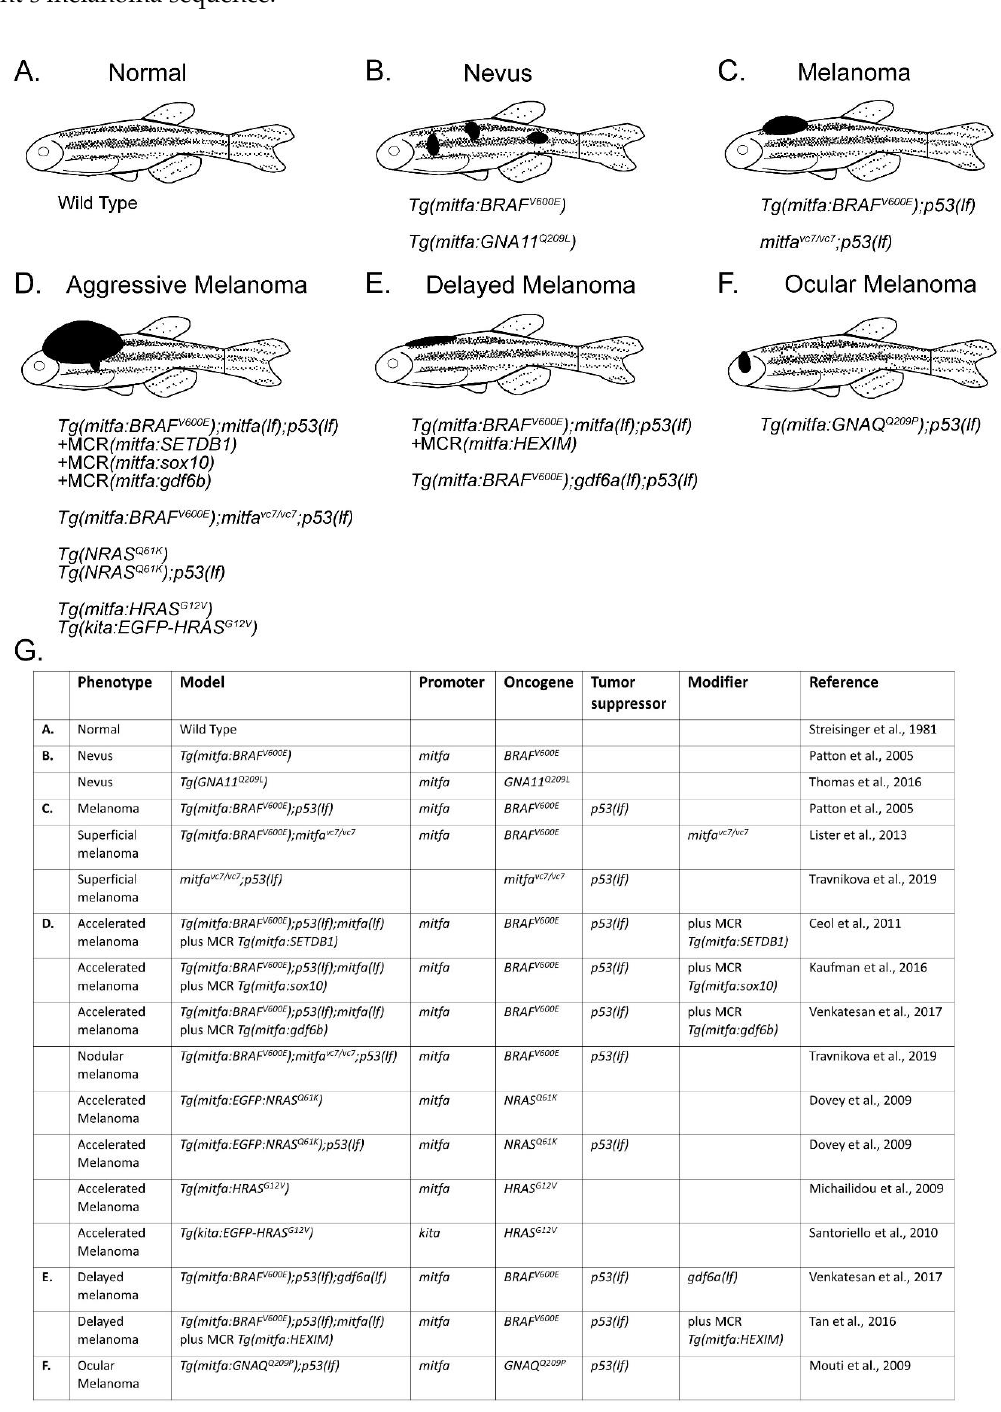
Figure 1. Genetic models of melanoma in zebrafish. ( A ) Normal melanocyte pattern in wild-type zebrafish. ( B ) Nevus formation with the introduction of human B-Raf proto-oncogene, serine / threonine kinase ( BRAF V600E ) or G protein subunit alpha 11 ( GNA11 Q209L ) under the zebrafish microphthalmia-associated transcription factor alpha ( mitfa ) promoter [13,44]. ( C ) Melanoma formation with the introduction of human BRAF V600E in a p53 loss-of-function (lf) or mitfa(vc7) background [13,45]. ( D ) Melanoma modifiers introduced into the Tg(mitfa:BRAF V600E ); p53(lf) model